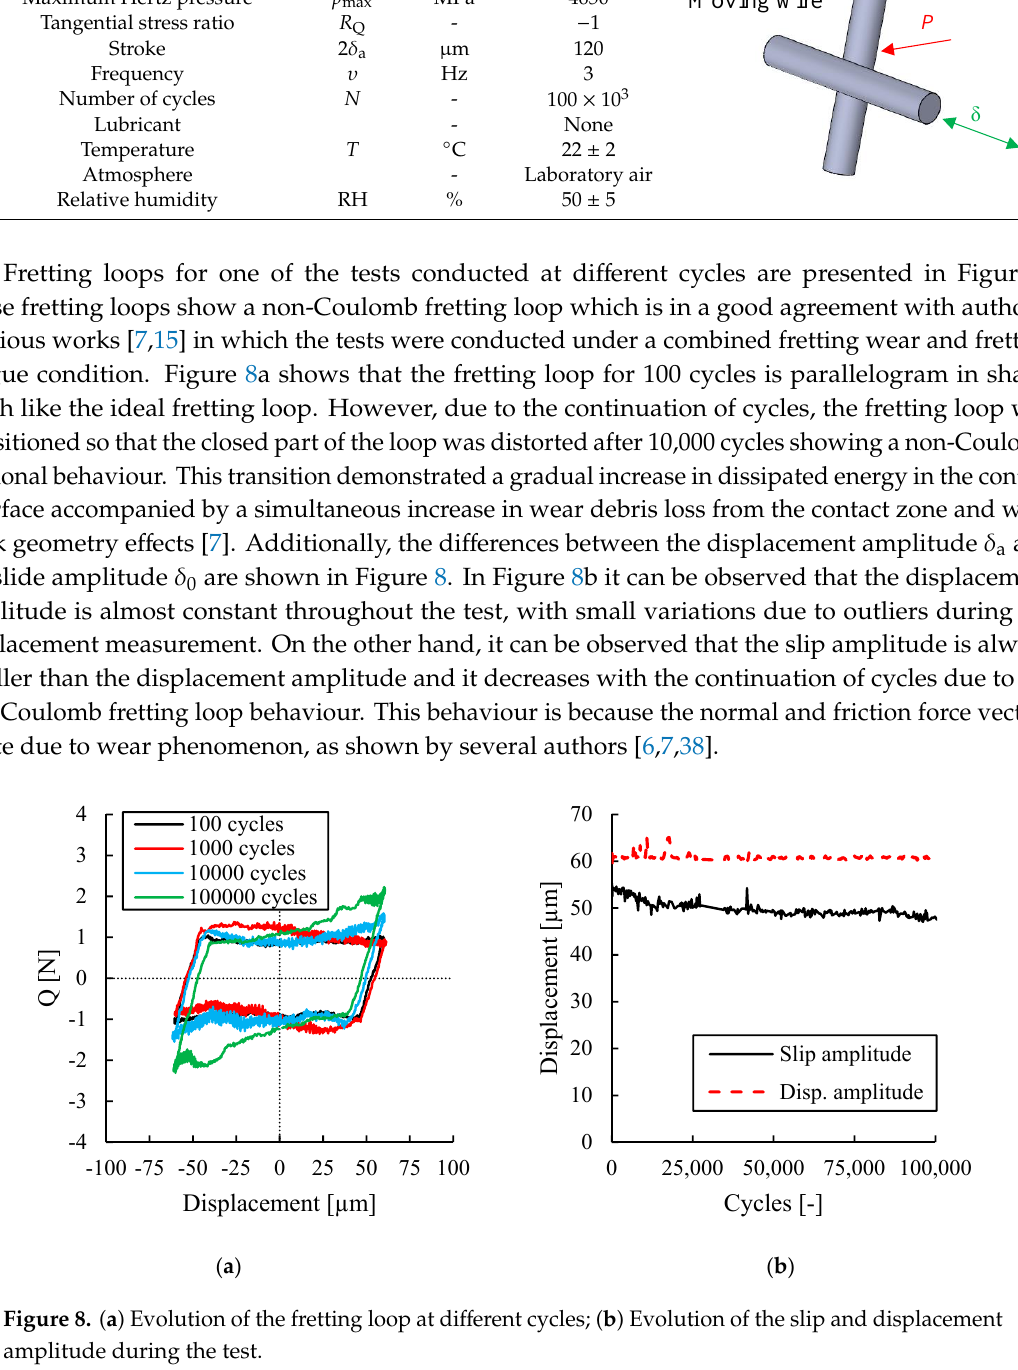
displacement amplitude during the test. amplitude during the